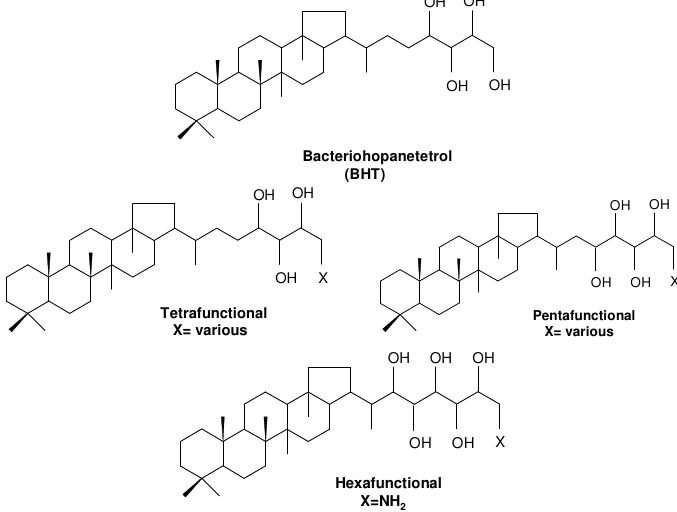
Figure 1. The characteristic base structure of